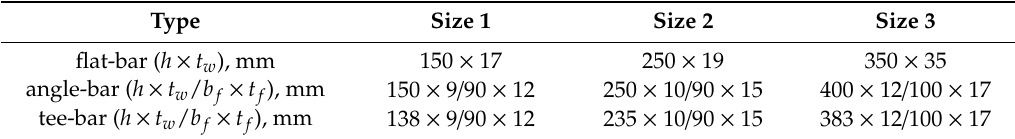
Table 1. Dimensions of sti ff eners.